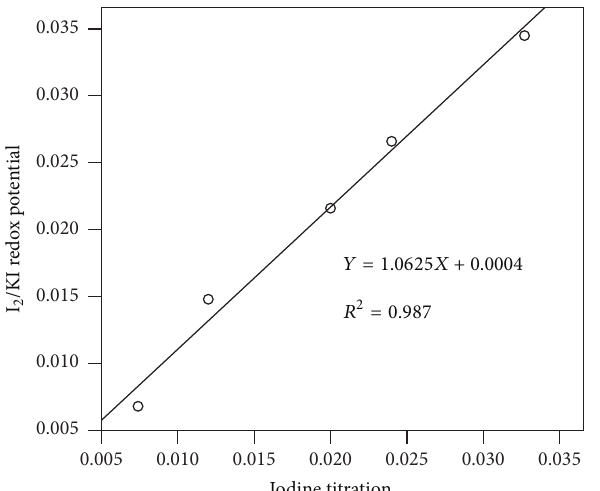
Figure 6: Liner relationship between 𝑛 (I 2 consumption) calculated by iodine titration method and that by I 2 /KI redox potential method.